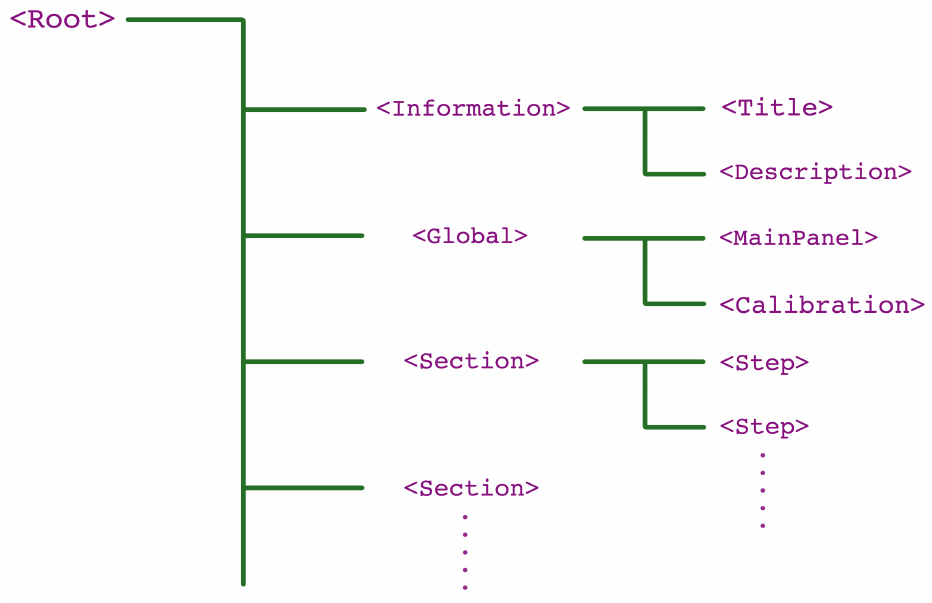
Figure 18. Structure of contents description